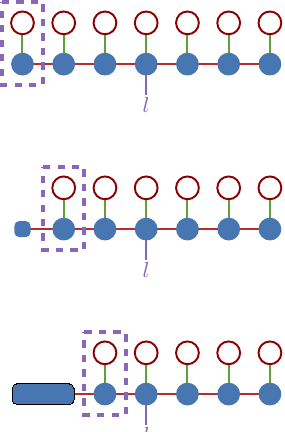
Figure 5 . Schematic representation of the contraction sequence of MPS, dashed line shows the contraction with the feature space at each step and rectangular node represents the vertical con- tractions. The figure evolves from top to